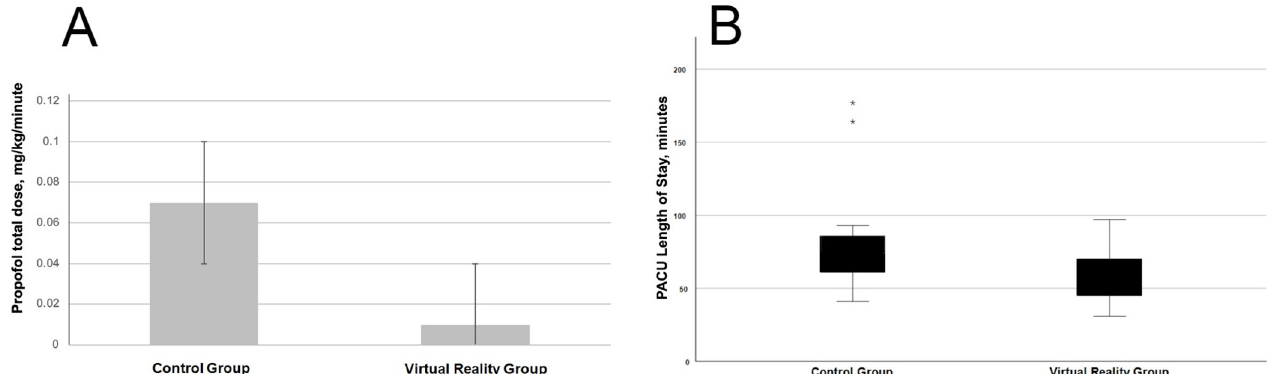
2), p = 0.68). Notably, the patients in the treatment group had a median 97% (IQR 79–100) agreement with the statement “I remember being aware of how I felt while I was in the operat- ing room” in comparison to 0% (IQR 0–0) (p < 0.001) in the control group. The one-month postoperative Quick DASH scores were not statistically significant between VR and control groups (20.5 (9.1–40.9) vs 40.9 (27.3–59.1), p = 0.056). A post hoc analysis did not reveal a sig- nificant difference between pre- and post-operative Quick DASH scores between groups (-7.9 (-21.1–1.2) vs 4.3 (-11.4–16.9), VR vs control, p = 0.22).